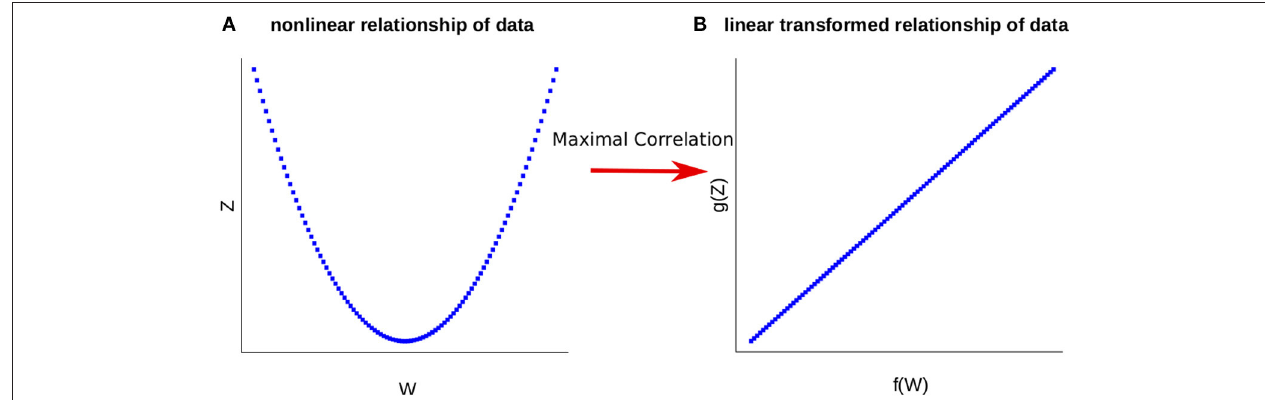
table challenging (e.g. Nguyen et al. (2014) analyzed maximal correlation with at least 100 data points which is still not available for metabolomics